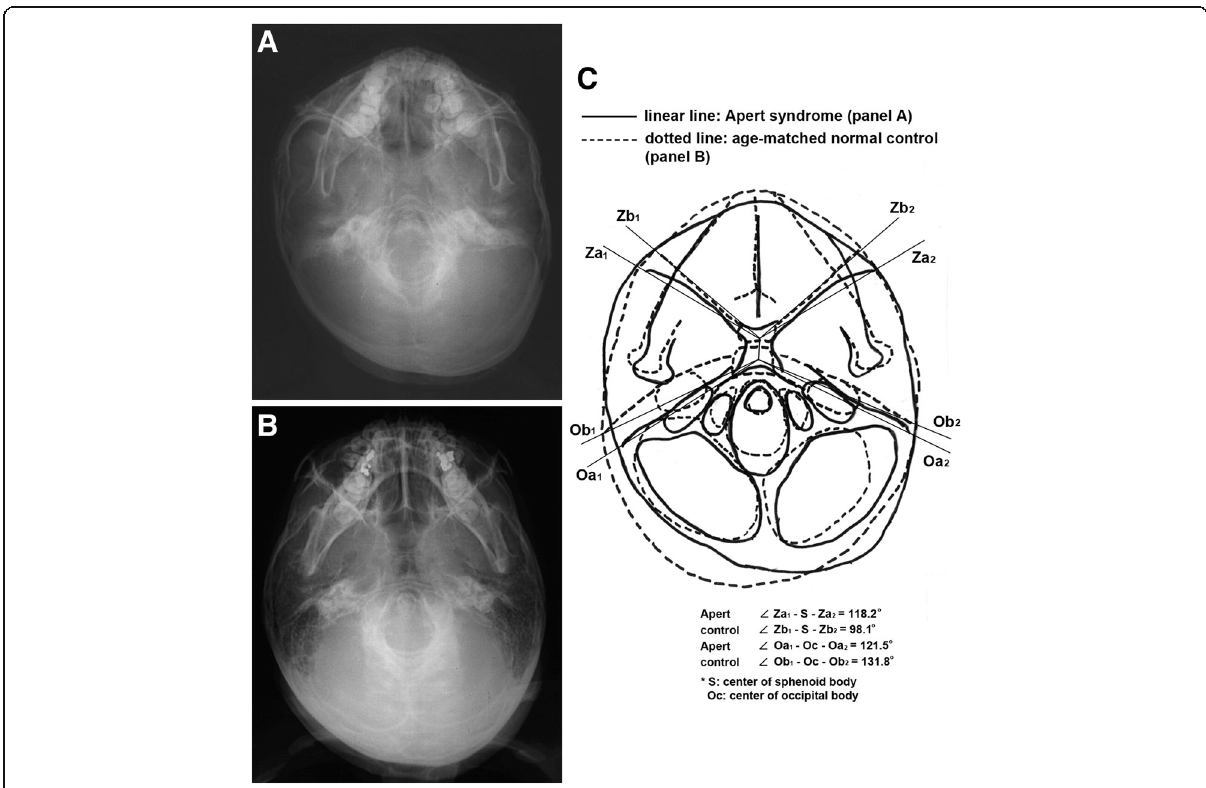
Fig. 6 Basal cranial view. a An Apert syndrome patient, a 9-year-old male. b A 9-year-old normal male. c Overlapping panels a and b . The Apert syndrome patient showed increased zygomatic axis angle of the cranial base (angle Z1-S-Z2) and decreased otic axis angle of the cranial base (angle O1-Oc-O2) compared to the